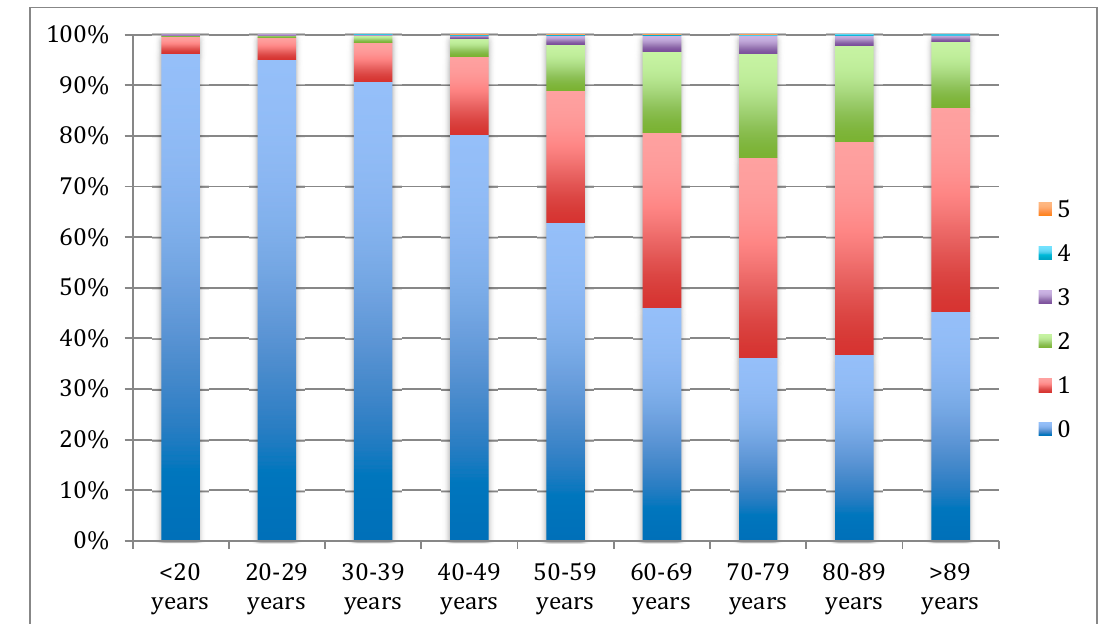
Figure 2. Number of metabolic comorbidities in stone patients by age (%).